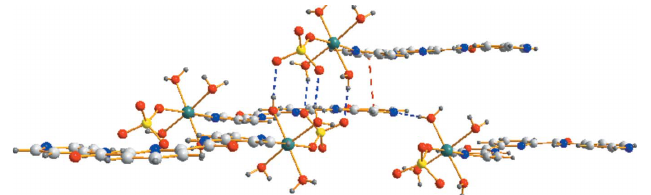
Figure 5 The weak interactions between molecules of complex (II) with hydrogen- bonding interactions and (cid:2) – (cid:2) interactions shown as blue and red dashed lines,